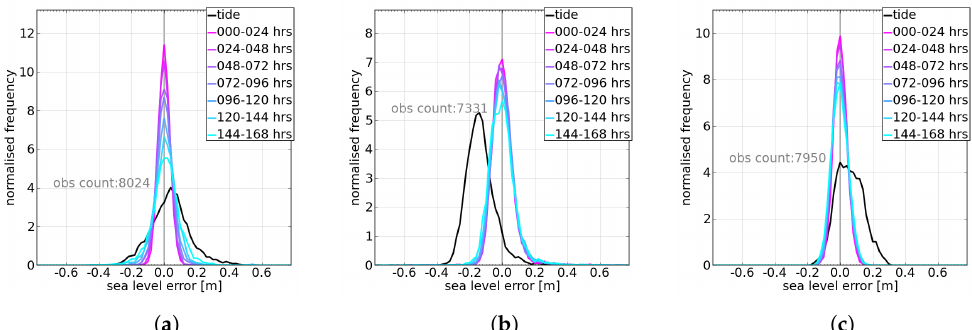
Figure 6. Forecast error distributions at selected contrasting locations. Skill improvement over standard harmonic tides is driven by different aspects of the generic aggregation process. ( a ) shows skill gain due to forecast signals associated with mid-latitudee weather ( b ) shows the practical problem of mismatched reference datums between real-time observational data and tide predictions (see Section 4), ( c ) is a location at which longer period deviations from tide predictions are relatively powerful. ( a ) Site 13, Mid-latitude weather; ( b ) Site 43, Tide datum mismatch; ( c ) Site 3, Long period anomalies.